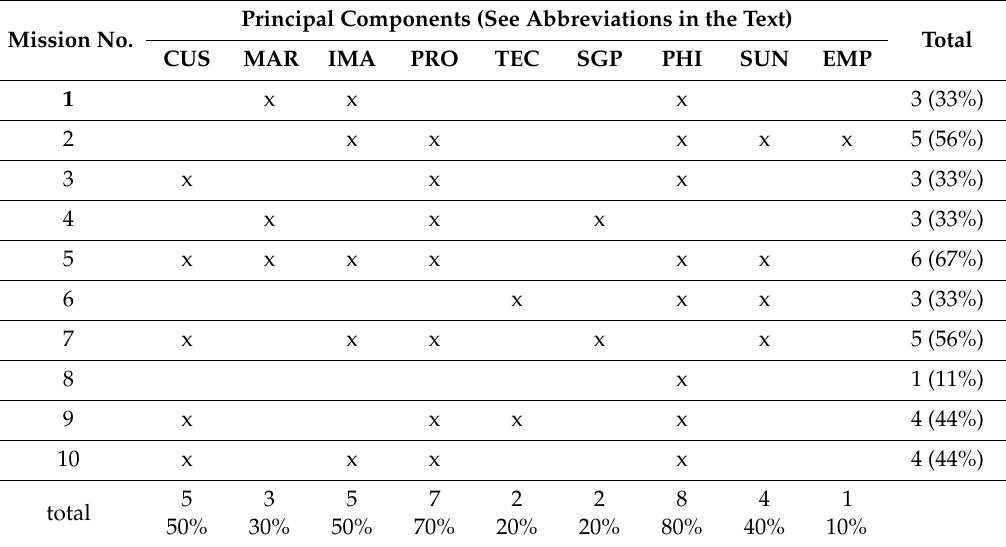
Table 2. Summary of the analyzed mission statements of Russian cheese producers. Principal Components (See Abbreviations in the Text) Mission No.